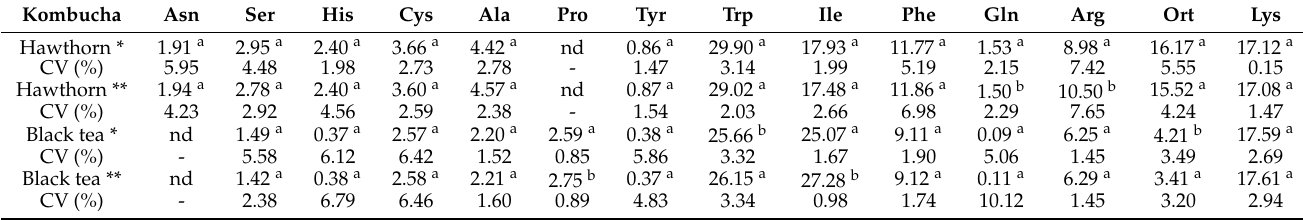
Table 2. Comparison of results for FAAs determination after derivatization procedure with and without